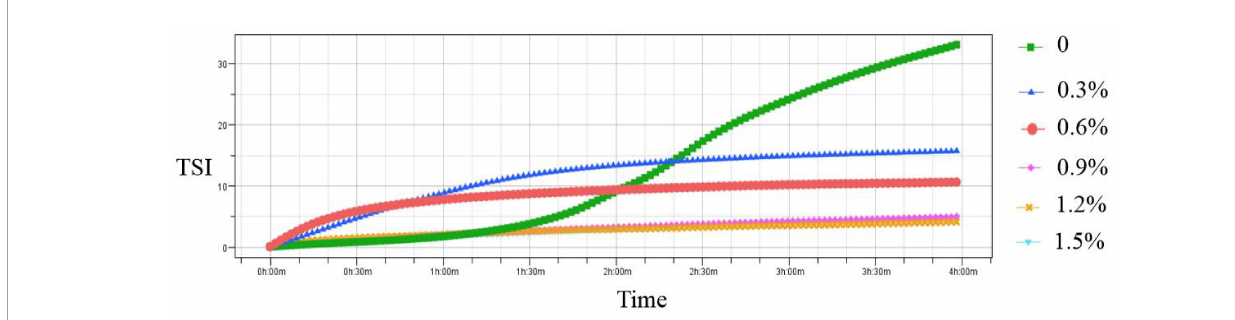
FIGURE2 The TSI values of the fresh emulsions with different concentrations of compound fibers.